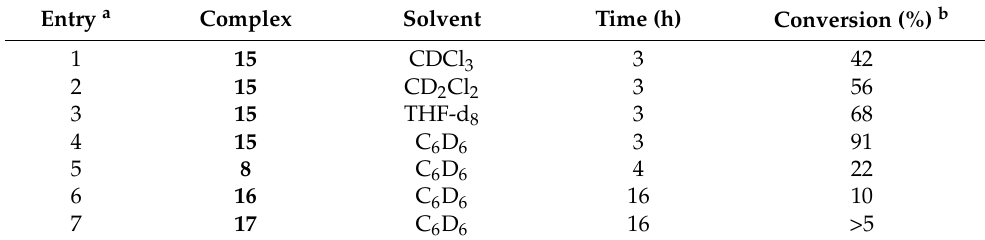
Table 2. Catalytic hydroamination of 1-hexyne with hydrazine.